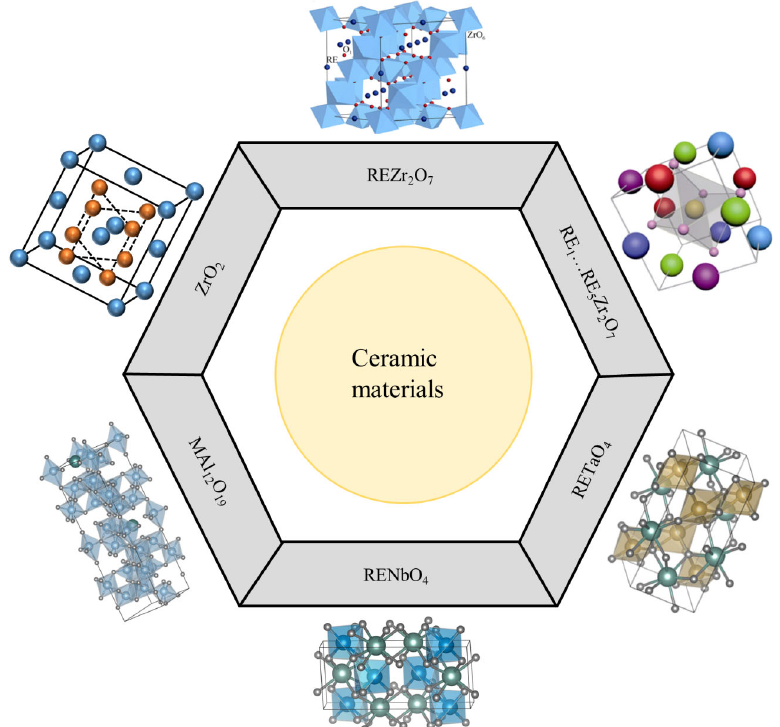
Fig. 3 Crystal structures of conventional zirconia, rare-earth zirconate, and some promising ceramic materials used for the top coat of TBCs. Reproduced with permission from Ref. [2], © The Nonferrous Metals Society of China and Springer-Verlag GmbH Germany, part of Springer Nature 2019; Ref. [15], © The Author(s)